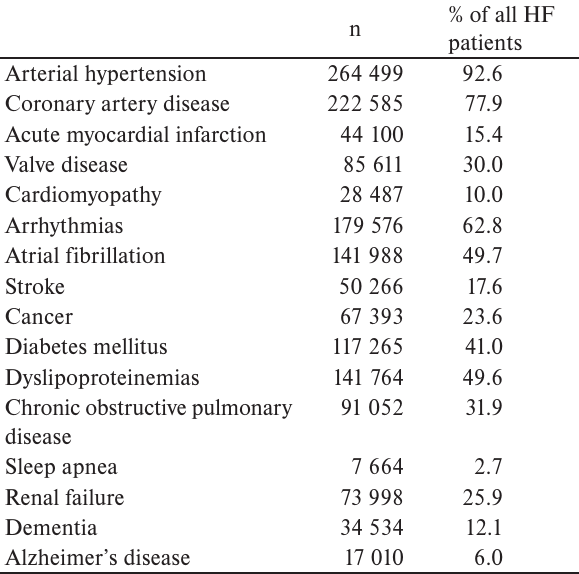
Table 2. Comorbidities in HF patients in